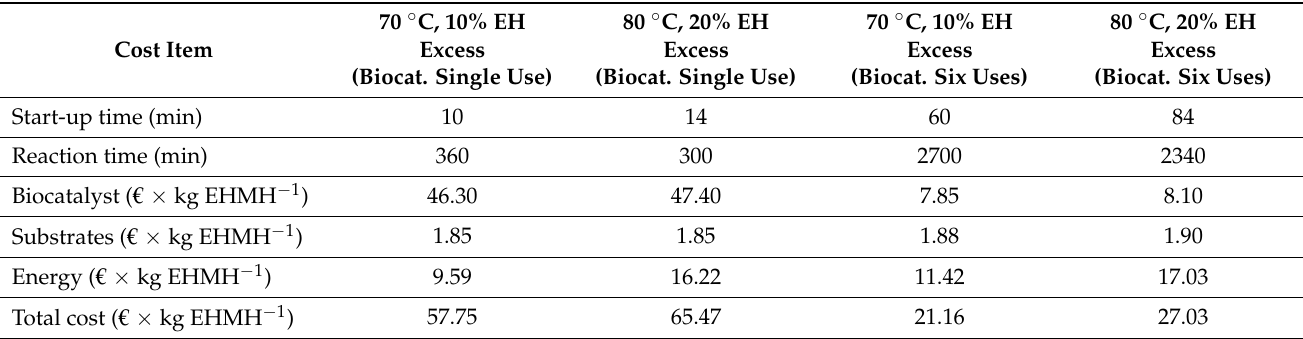
Table 5. Contribution of the biocatalyst, substrates and energy to the direct operation costs of the synthesis of EHMH at laboratory scale with a single use and six uses of